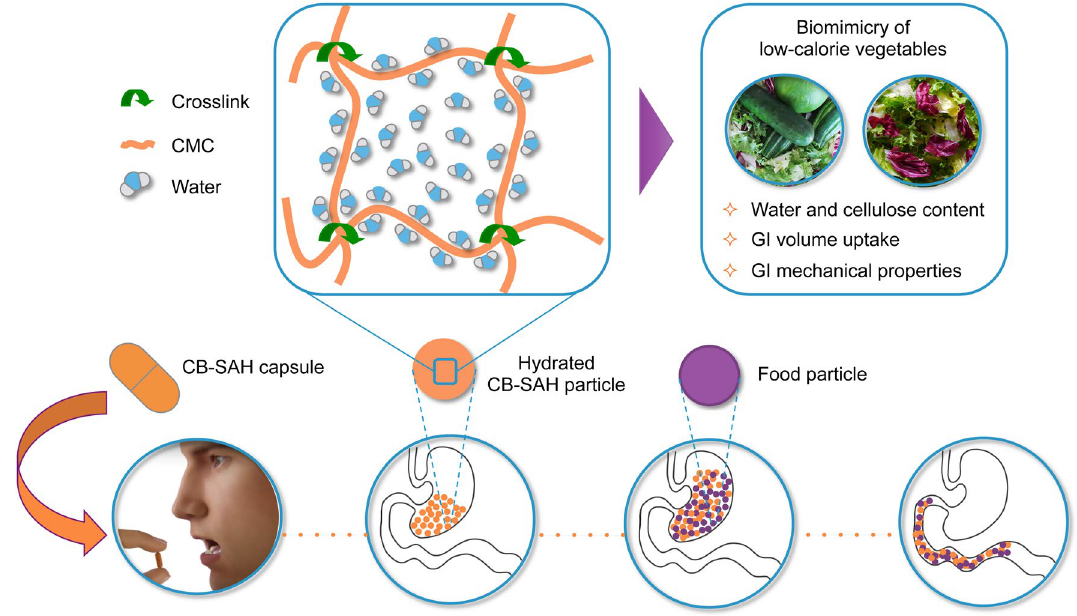
Figure 1. Design of biomimetic CB-SAHs for weight management. Taking inspiration from basic compositional and structural properties of raw vegetables while in transit through the GI tract, we designed novel CB-SAHs based on crosslinked carboxymethylcellulose sodium salt (CMC). The CB-SAHs are orally administered in capsules, hydrate in the stomach, mix up with the ingested food, and move along the small intestine without being absorbed. Once in the colon (not depicted in the scheme), they undergo partial degradation to return the absorbed water to the body, while the cellulosic material is excreted with the